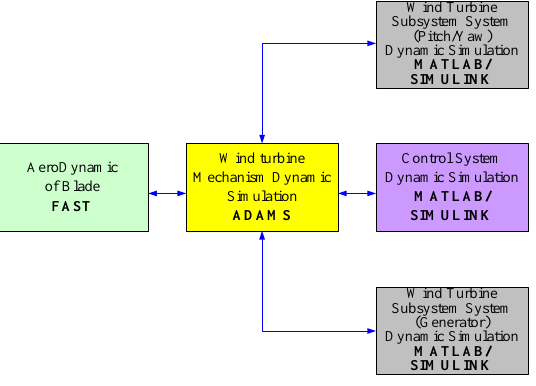
Figure 1. Co-simulation of FAST (aerodynamics), ADAMS (mechanism dynamic), and MATLAB/SIMULINK (subsystems and control system) for wind turbines.